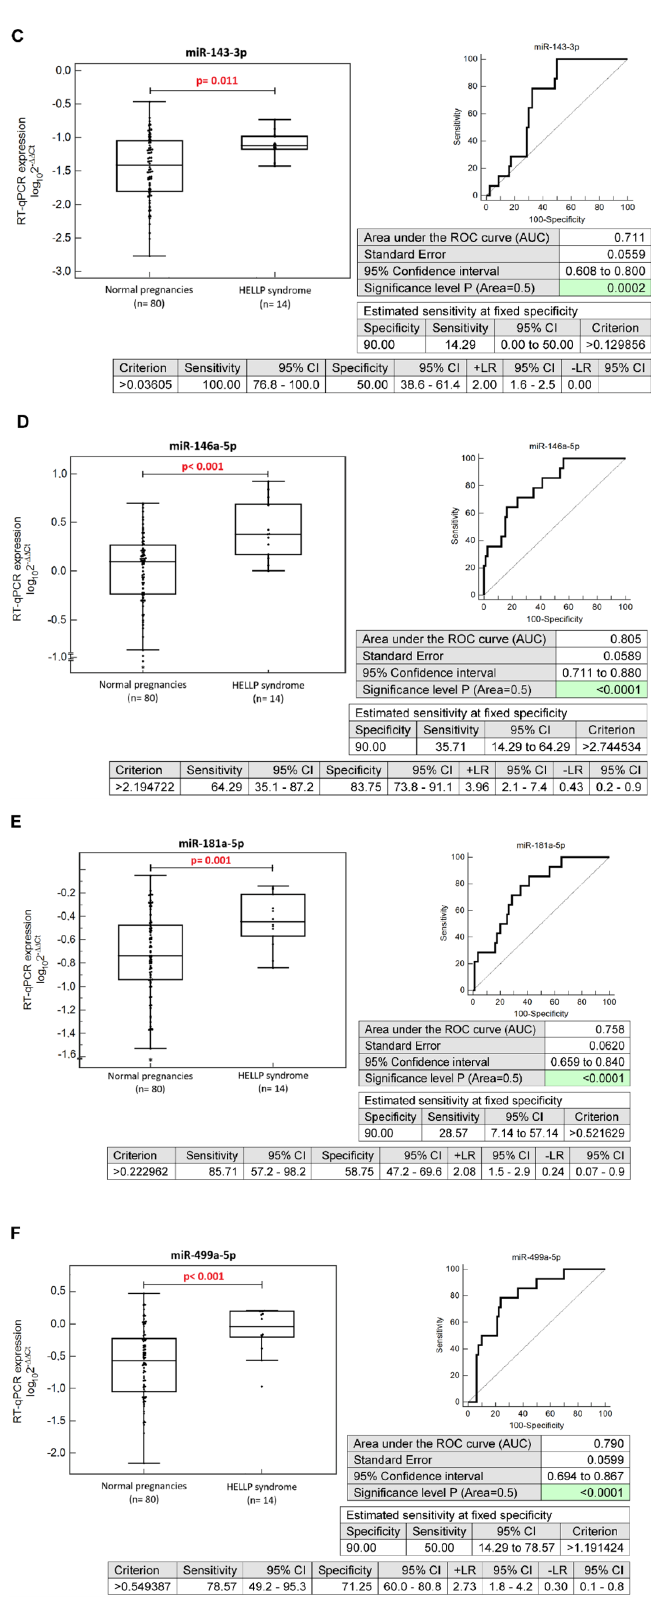
Figure 1. Differentiation between patients with HELLP-syndrome and normal-term pregnancies at early gestational stages based on peripheral blood microRNA expression profiles. Up-regulation of miR-1-3p ( A ), miR-17-5p ( B ), miR-143-3p ( C ), miR-146a-5p ( D ), miR-181a-5p ( E ), and miR-499a-5p ( F ) was observed. CI, confidence interval; +LR, positive likelihood ratio; −LR, negative likelihood ratio. 2.3. The Prediction Model for HELLP Syndrome — The Combination of Six MicroRNAs Only The prediction model for HELLP syndrome based on the combination of six mi- croRNAs only (miR-1-3p, miR-17a-5p, miR-143a-3p, miR-146a-5p, miR-181a-5p, and miR- 499a-5p) identified pregnancies developing HELLP syndrome with relatively high accu- racy (AUC 0.903, p < 0.001, 78.57% sensitivity, 93.75% specificity, cut-off >0.1622). A total of 78.57% of pregnancies destined to develop HELLP syndrome was revealed at early stages of gestation with a 10.0% FPR (Figure 2).